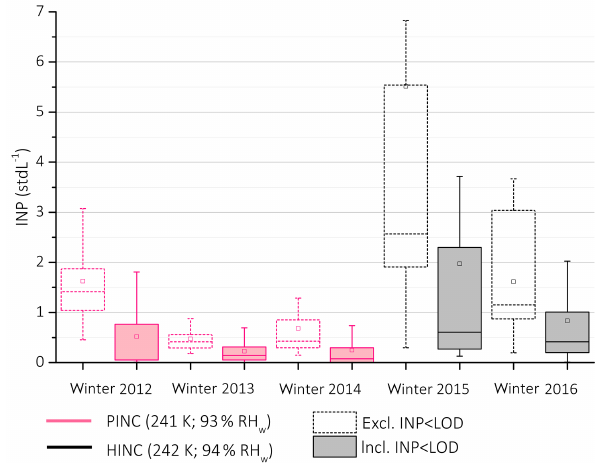
Figure 8. Averaged INP concentrations observed below water sat- uration (see legend for exact temperature and RH conditions). Dashed box plots represent only INPs > LOD; solid box plots in- clude INPs < LOD (see Sect. 2.3 for details). Median: middle bar; mean: open square data point; box: interquartile range (25th to 75th percentiles); whiskers: 5th and 95th percentiles. Data used to produce the distributions exclude contributions from measurements during periods of SDEs and air masses of marine influence at the JFJ (see Sect. 4.2) with anomalously high INP concentrations. See Table 1 for field campaign sampling